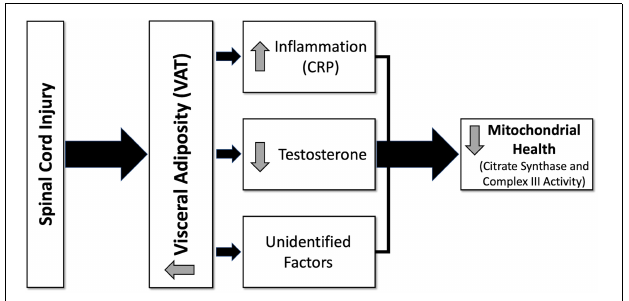
FIGURE 1 | Hypothesized diagram of factors predicting mitochondrial health following spinal cord injury (SCI). After SCI, visceral adiposity increases and releases inflammatory cytokines that negatively affect testosterone levels and mitochondrial health. Visceral adiposity, inflammation, and testosterone are involved in this deleterious process; however, there are still factors that remain unidentified. CRP, c-reactive protein; VAT, visceral adipose